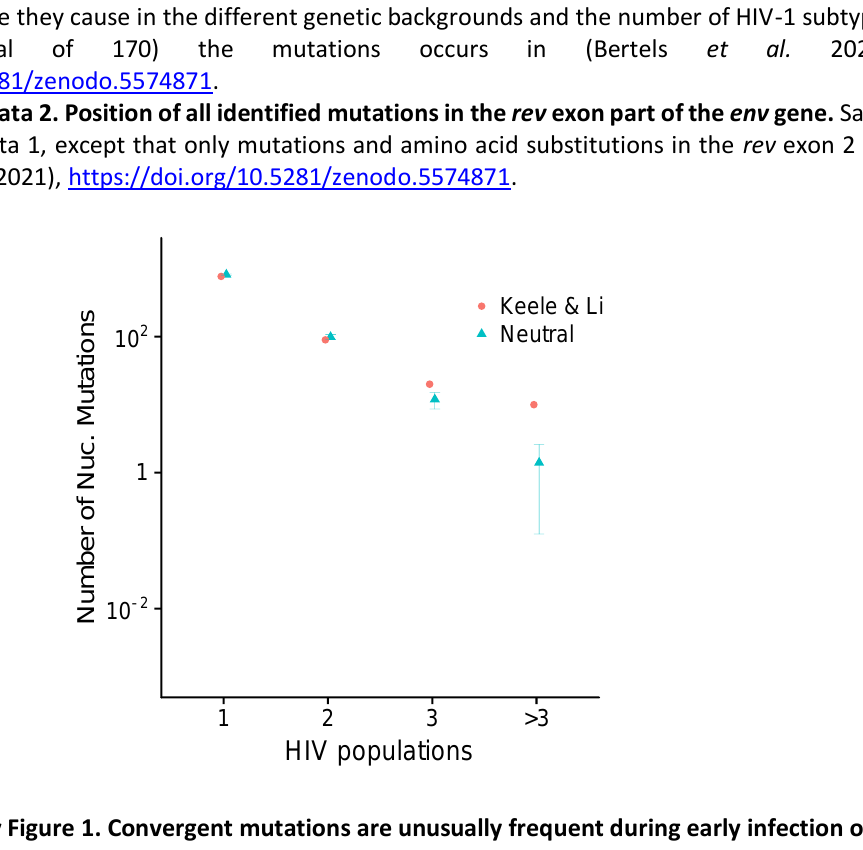
Supplementary Figure 1. Convergent mutations are unusually frequent during early infection of HIV-1. Same as Figure 1 except that mutations occurring in more than three HIV populations independently were grouped